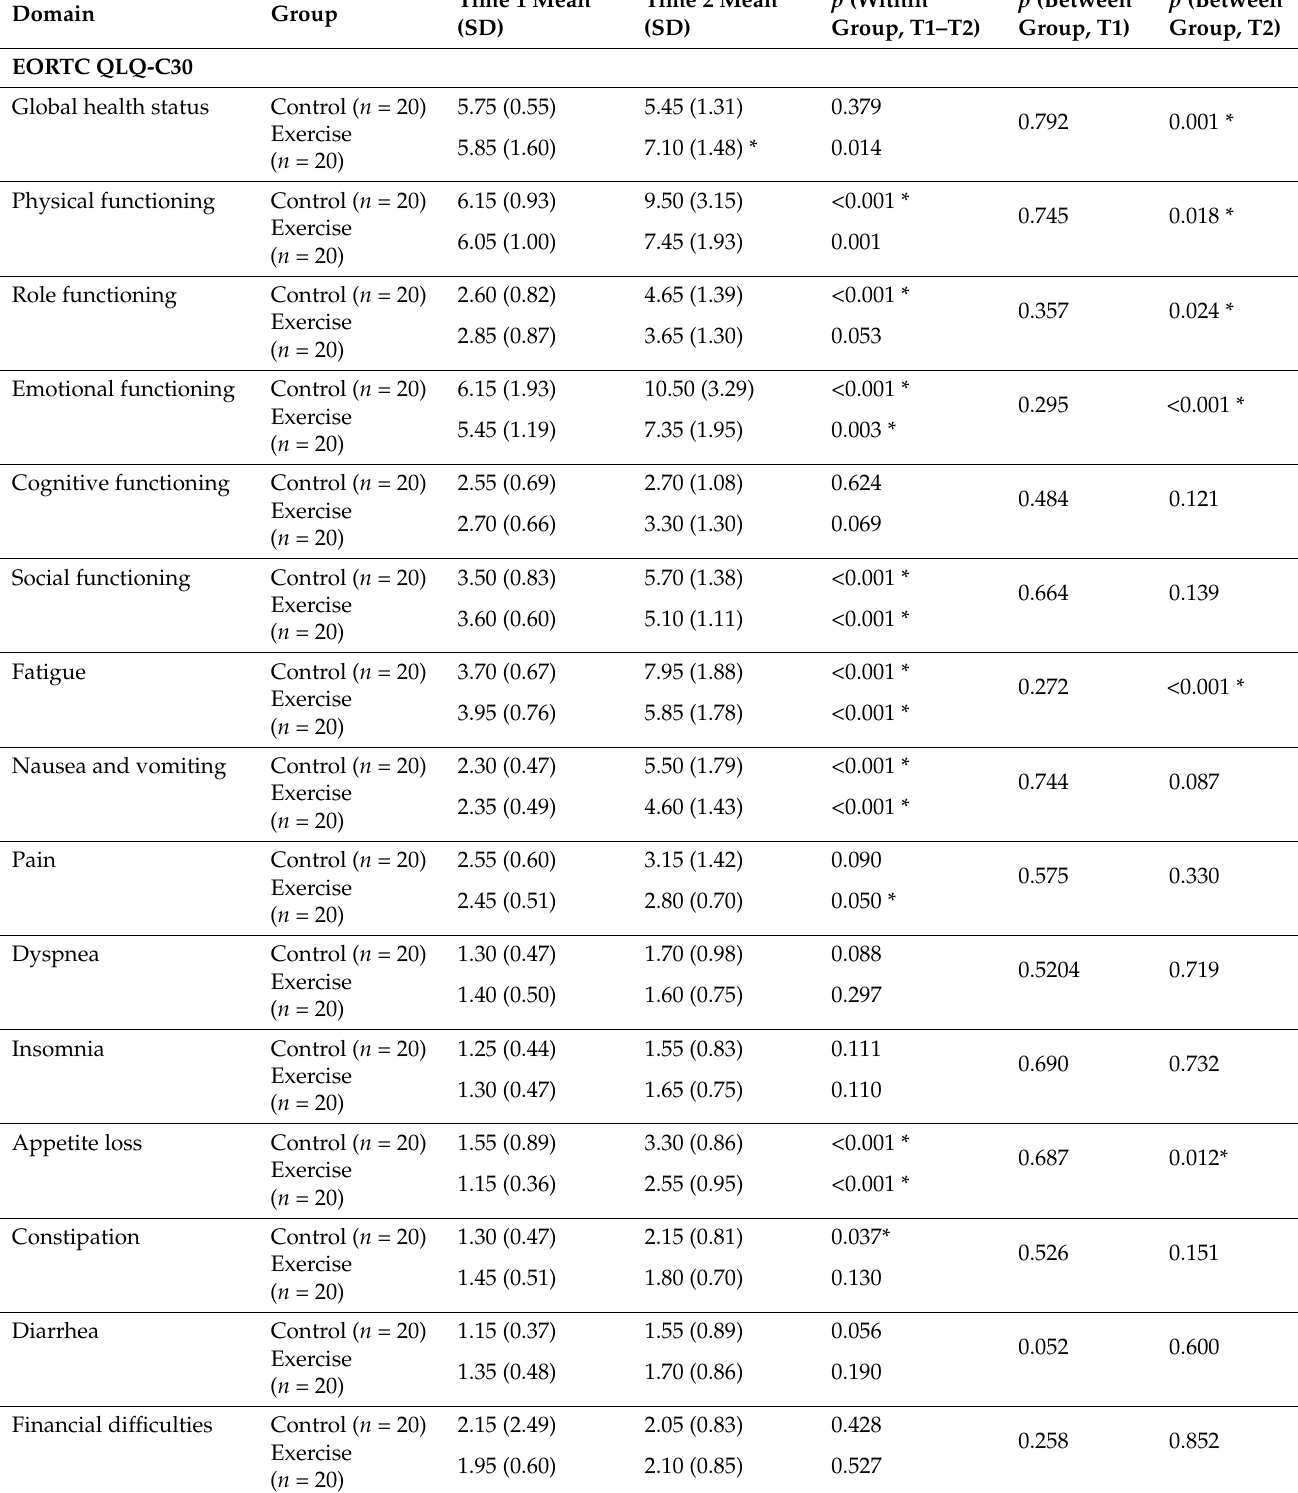
Table 5. Health-related quality of life between the exercise group and control group at pretest and